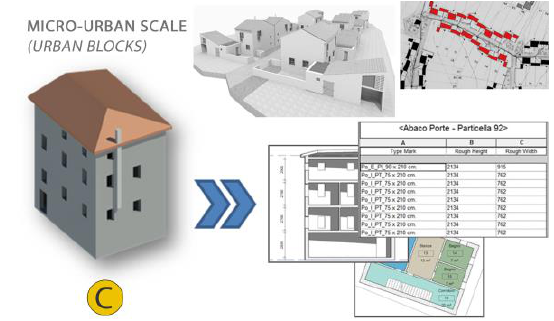
Figure 8. The Micro-urban scale (C): introduction of libraries of basic categorized parametric objects.